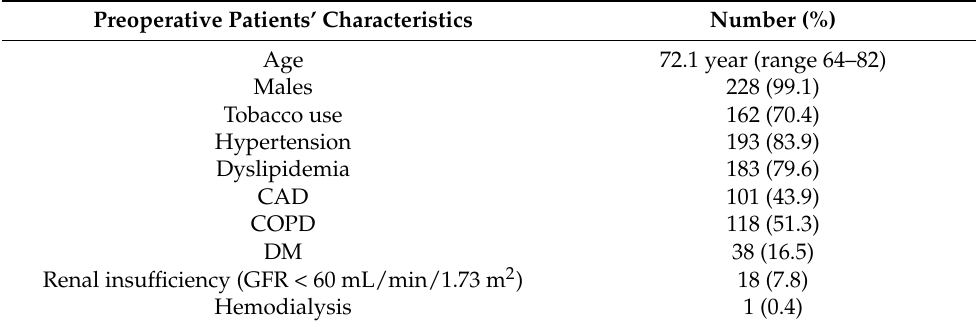
Table 1. Patients’ demographic characteristics and